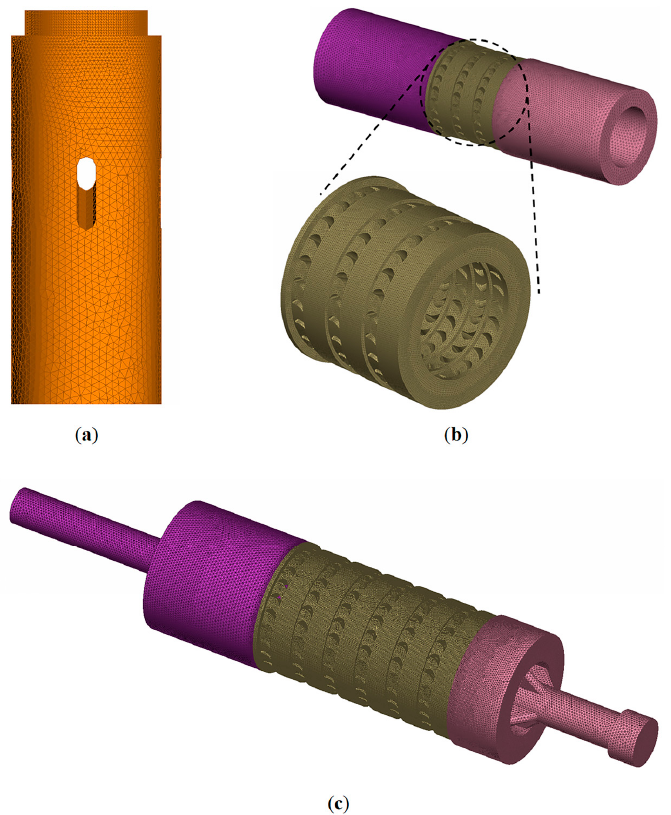
Figure 4. Meshing of the models: ( a ) meshing of the shaft model; ( b ) meshing of the fluid domain of